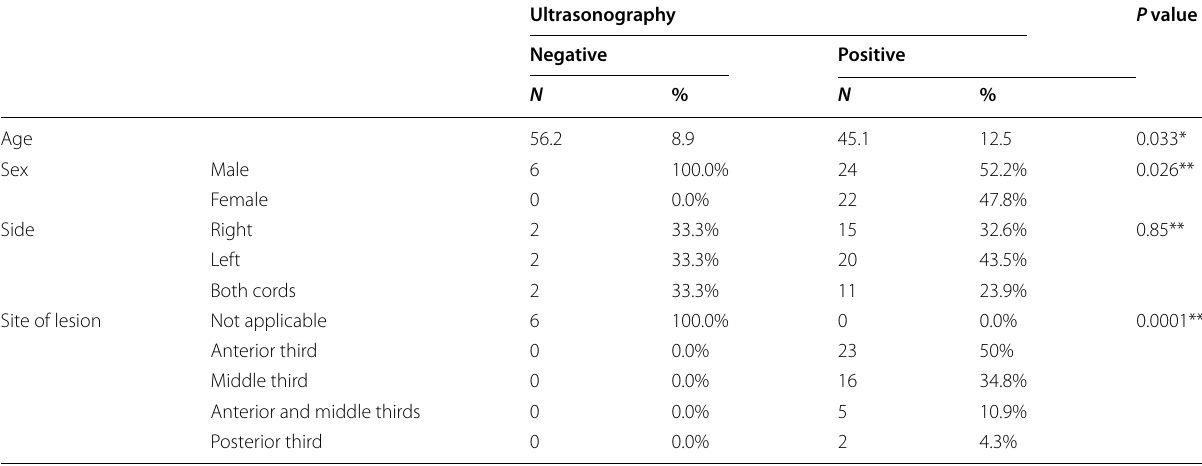
Table 2 The comparison of baseline characters based on the ultrasound